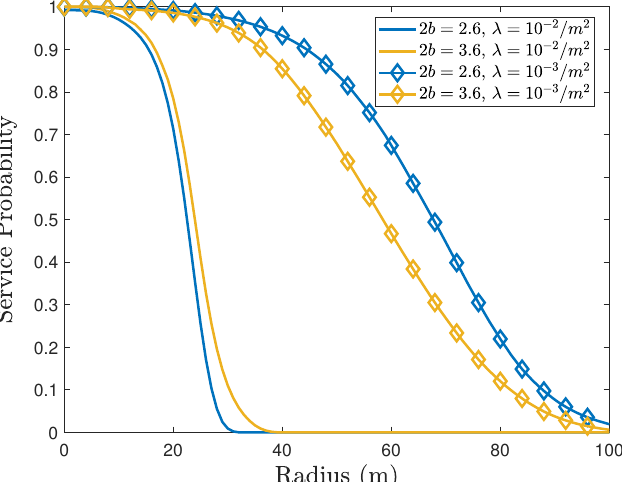
Figure 3. Service probability vs. radius R o for varying λ = { 10 − 2 ,10 − 3 } m − 2 , where the AP employs a UCA with N c = 128. Parameters: R max = 200 m, SIR threshold [ T ] dB = 0; normalized amplitude | β o | = 1; 2 b = 2.6 and 2 b = 3.6, h = 10 m.